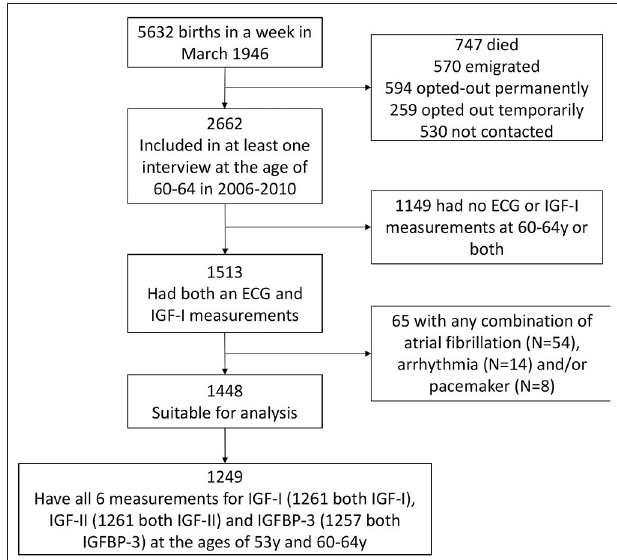
FIGURE 1 | Consort diagram of the recruitment process. The Medical Research Council National Survey of Health and Development (NSHD) consists of 5,362 individuals recruited in 1 week in March 1946 in Britain. The exposures of interest here were metabolic markers at 60–64 years while the outcome was QTc interval derived from resting 12-lead electrocardiography (ECG) during the same clinic visit. Both pieces of data were available for 1,513 out of the 5,362 participants. The number of participants involved int the study is presented in the figure below. ECG, electrocardiography; IGF-I, insulin-like growth factor 1; IGF-BP3, insulin-like growth factor binding protein